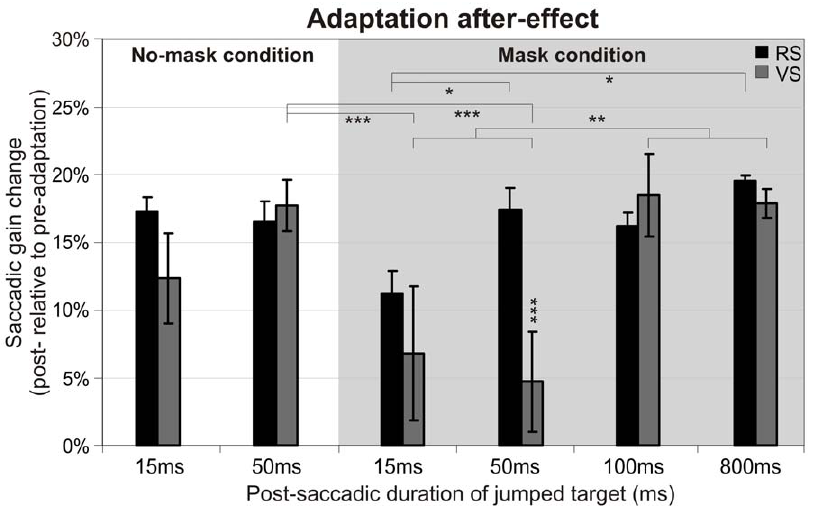
Figure 3. Adaptation after-effect for the different target durations and mask conditions. Mean gain changes for reactive saccades (black bars) and voluntary saccades (grey bars) calculated between the pre-adaptation and post-adaptation blocks. These gain changes are plotted as a function of target durations in the mask condition (grey background) and in the no-mask condition (white background). Error bars are SEMs. Significant differences of gain changes between the saccade categories, target durations and masking conditions are indicated by * (p , 0.05), ** (p , 0.01) and *** (p , 0.001).